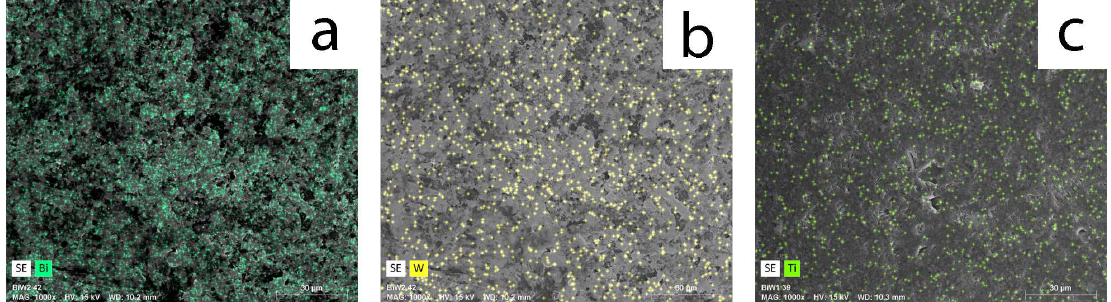
Figure 2. Results of elemental mapping for selected coatings: ( a ) sample BiW2 bismuth; ( b ) sample BiW2 tungsten; and ( c ) sample TiO 2 titanium.